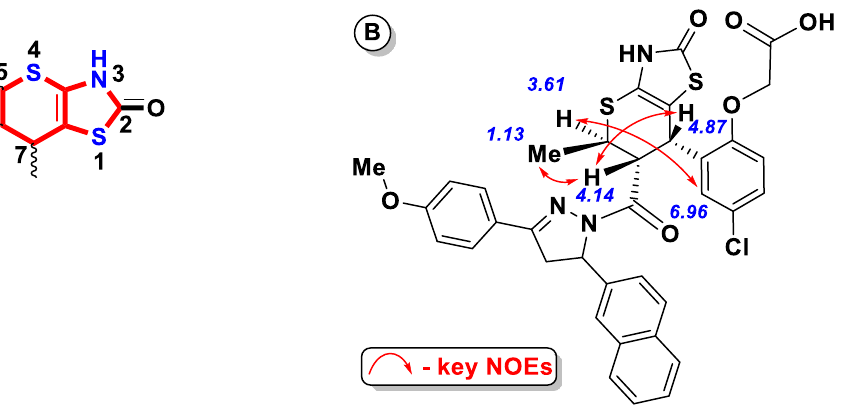
Figure 2. The scheme of atom numbering in the thiopyrano[2,3- d ]thiazole core ( A ) and key interactions in the relevant ROESY spectrum of compound 3 ( B ).